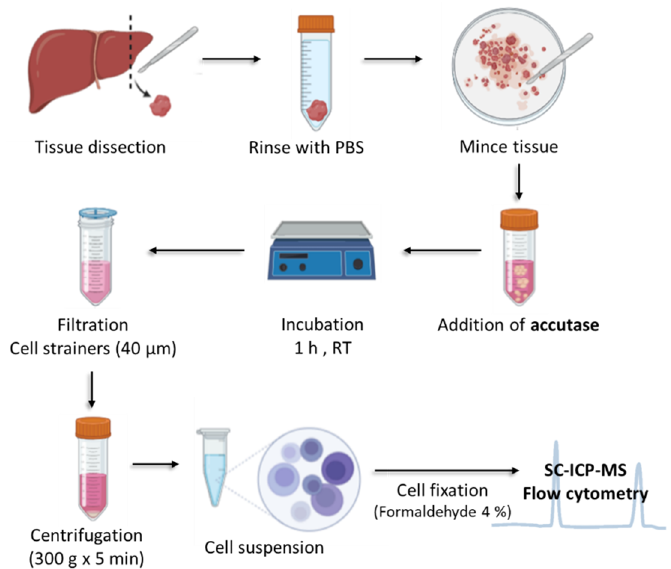
Figure 1. Workflow to prepare a single cell suspension from a solid tissue.